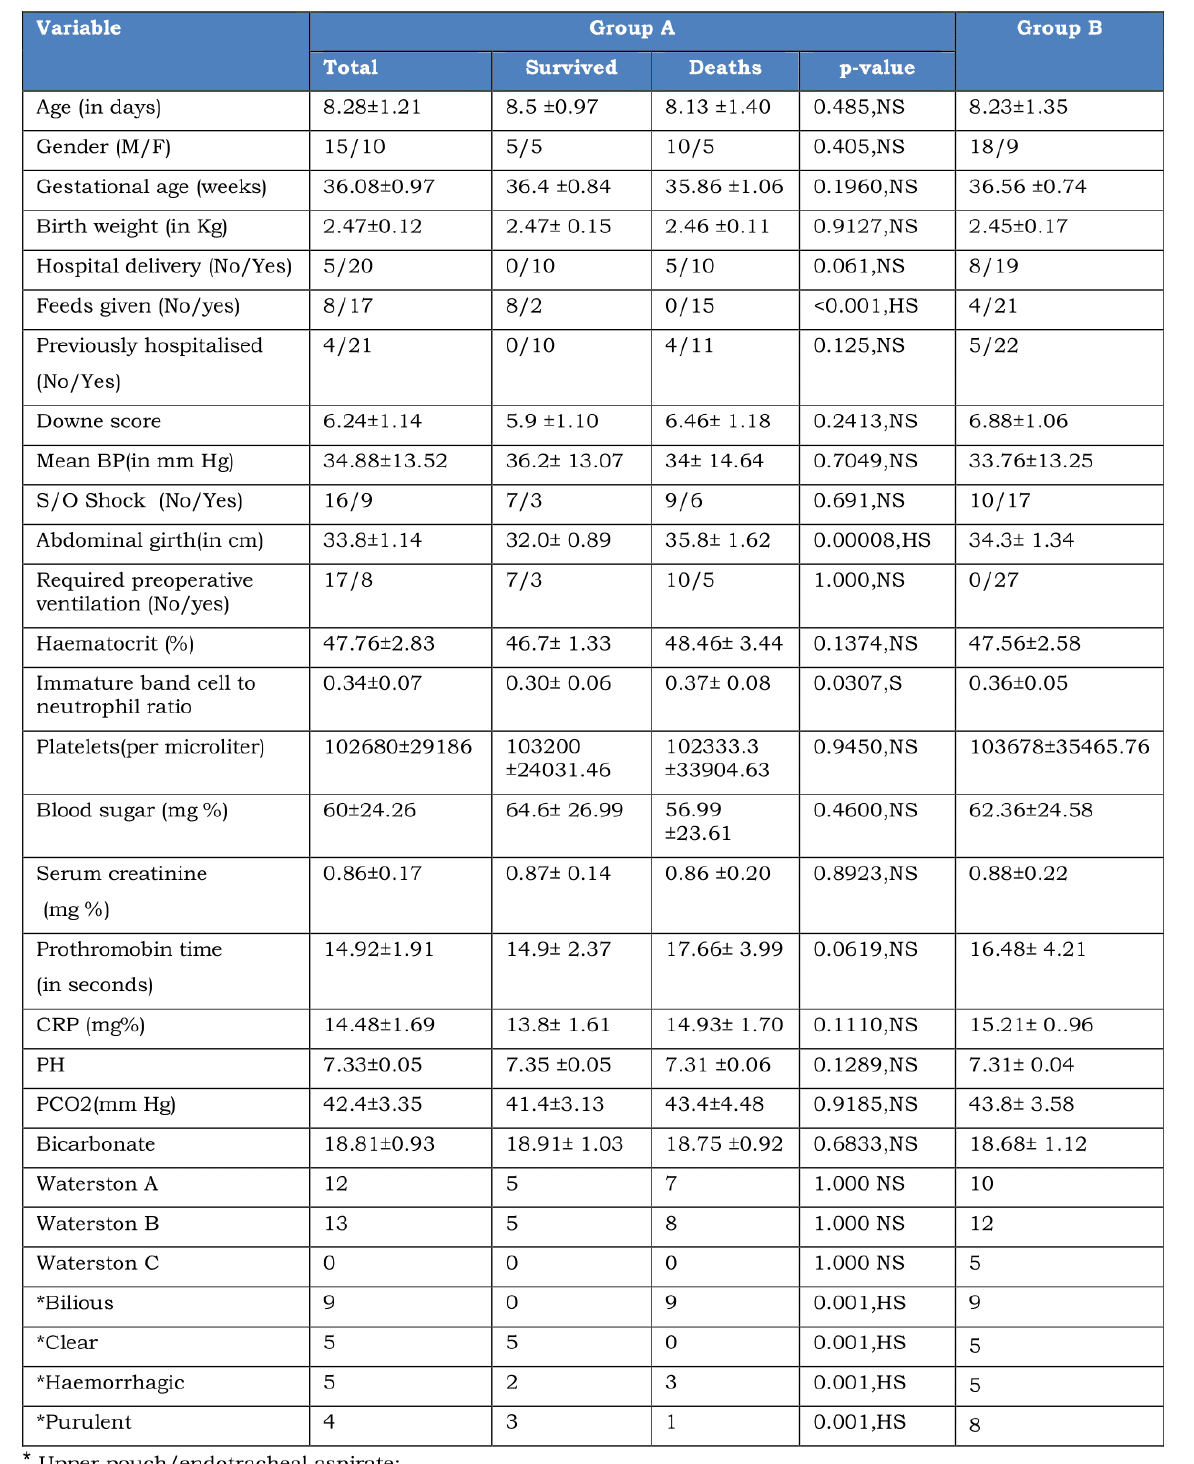
Table 3: Comparison of Clinical, Haematological and Biochemical Profile in Survivors and Non-